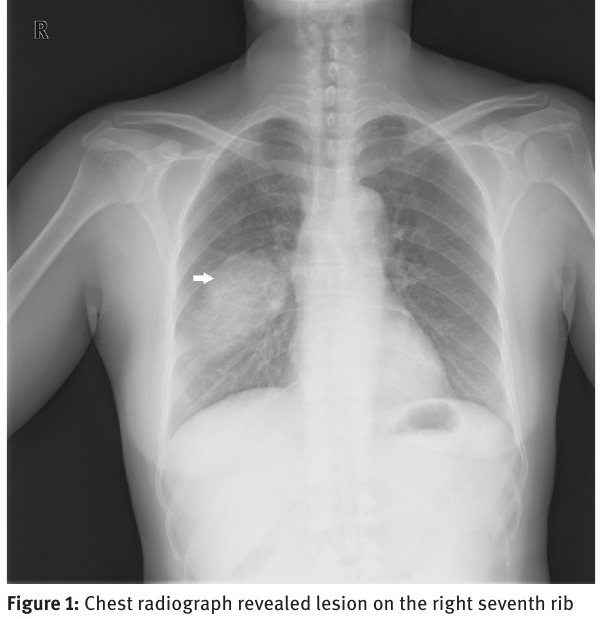
Figure 1: Chest radiograph revealed lesion on the right seventh rib (arrow).